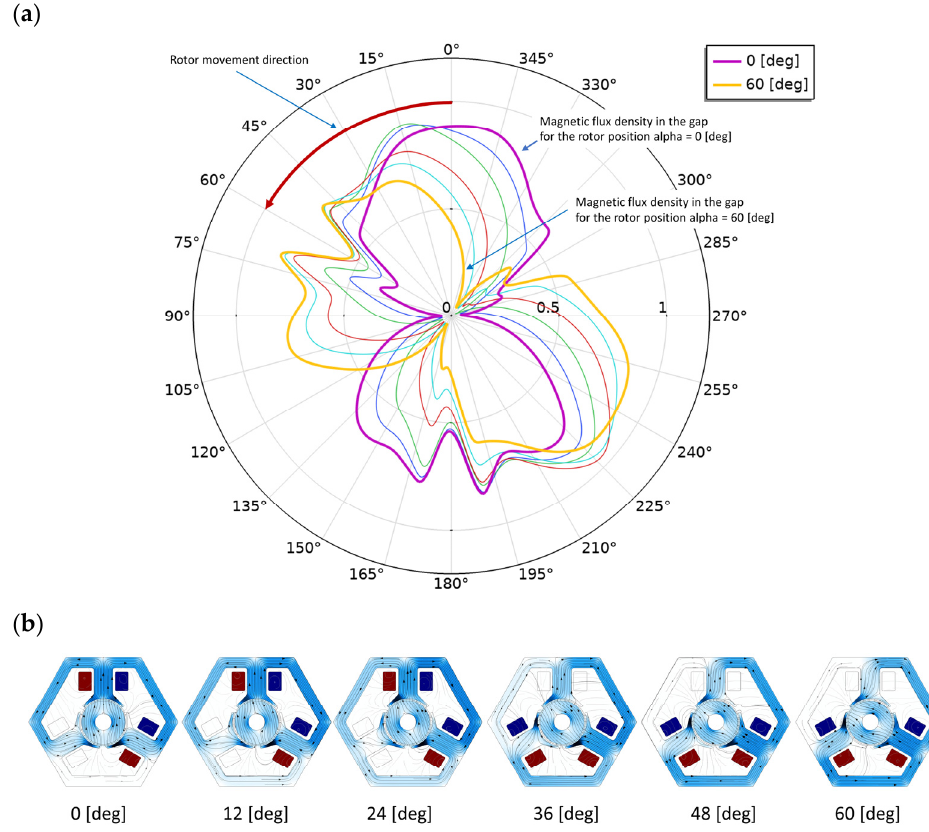
Figure 13. ( a ) Magnetic flux density in the gap for the rotor position from 0° to 60° for model B3.b. The following lines represent the rotor positions: 0° (purple), 12° (blue), 24° (green), 36° (red), 48° (turquoise) and 60° (yellow). Switching the coil voltage between 24° and 36° is considered. The radius corresponds to the magnetic flux density value in tesla. ( b ) Magnetic flux density and magnetic vector potential (lines) in successive rotor positions (rotated ever 12 degrees).